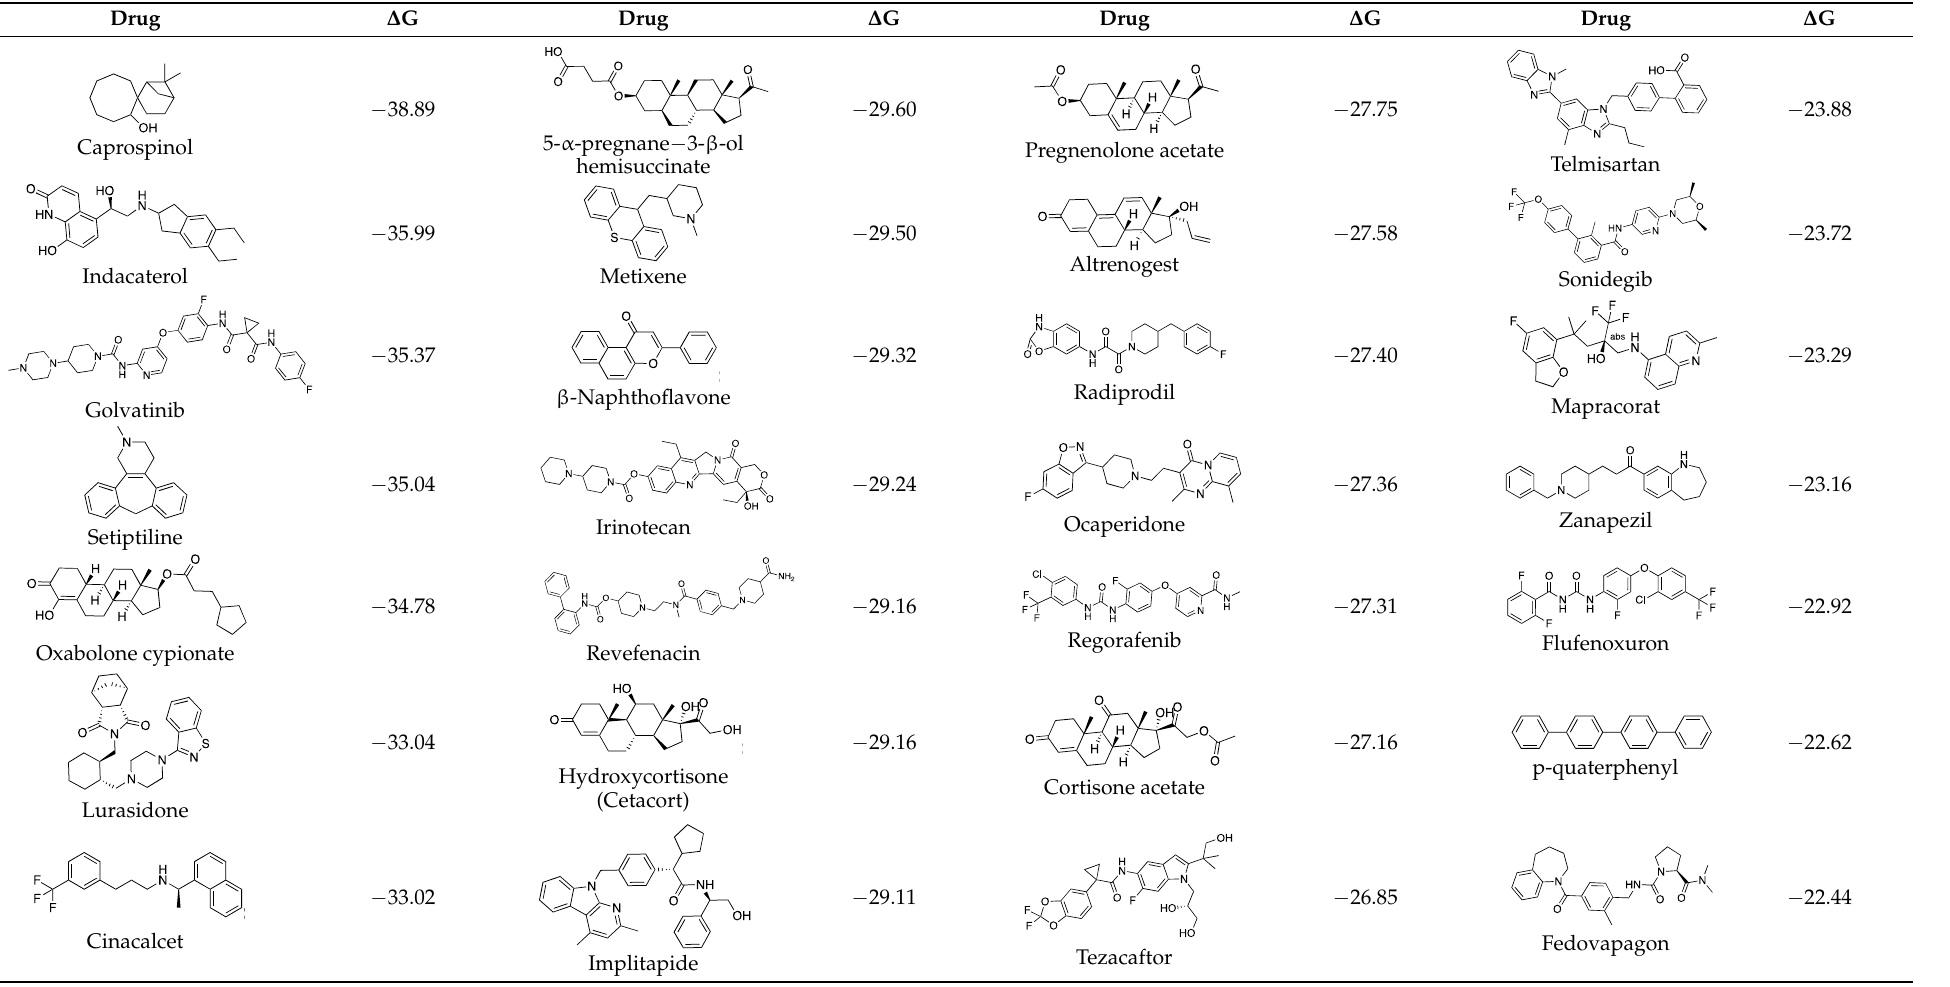
Table 1. MM/PBSA binding energies G (kcal/mol) of top 100 docking candidates. Estimated uncertainties in the binding energies were <1 kcal/mol.